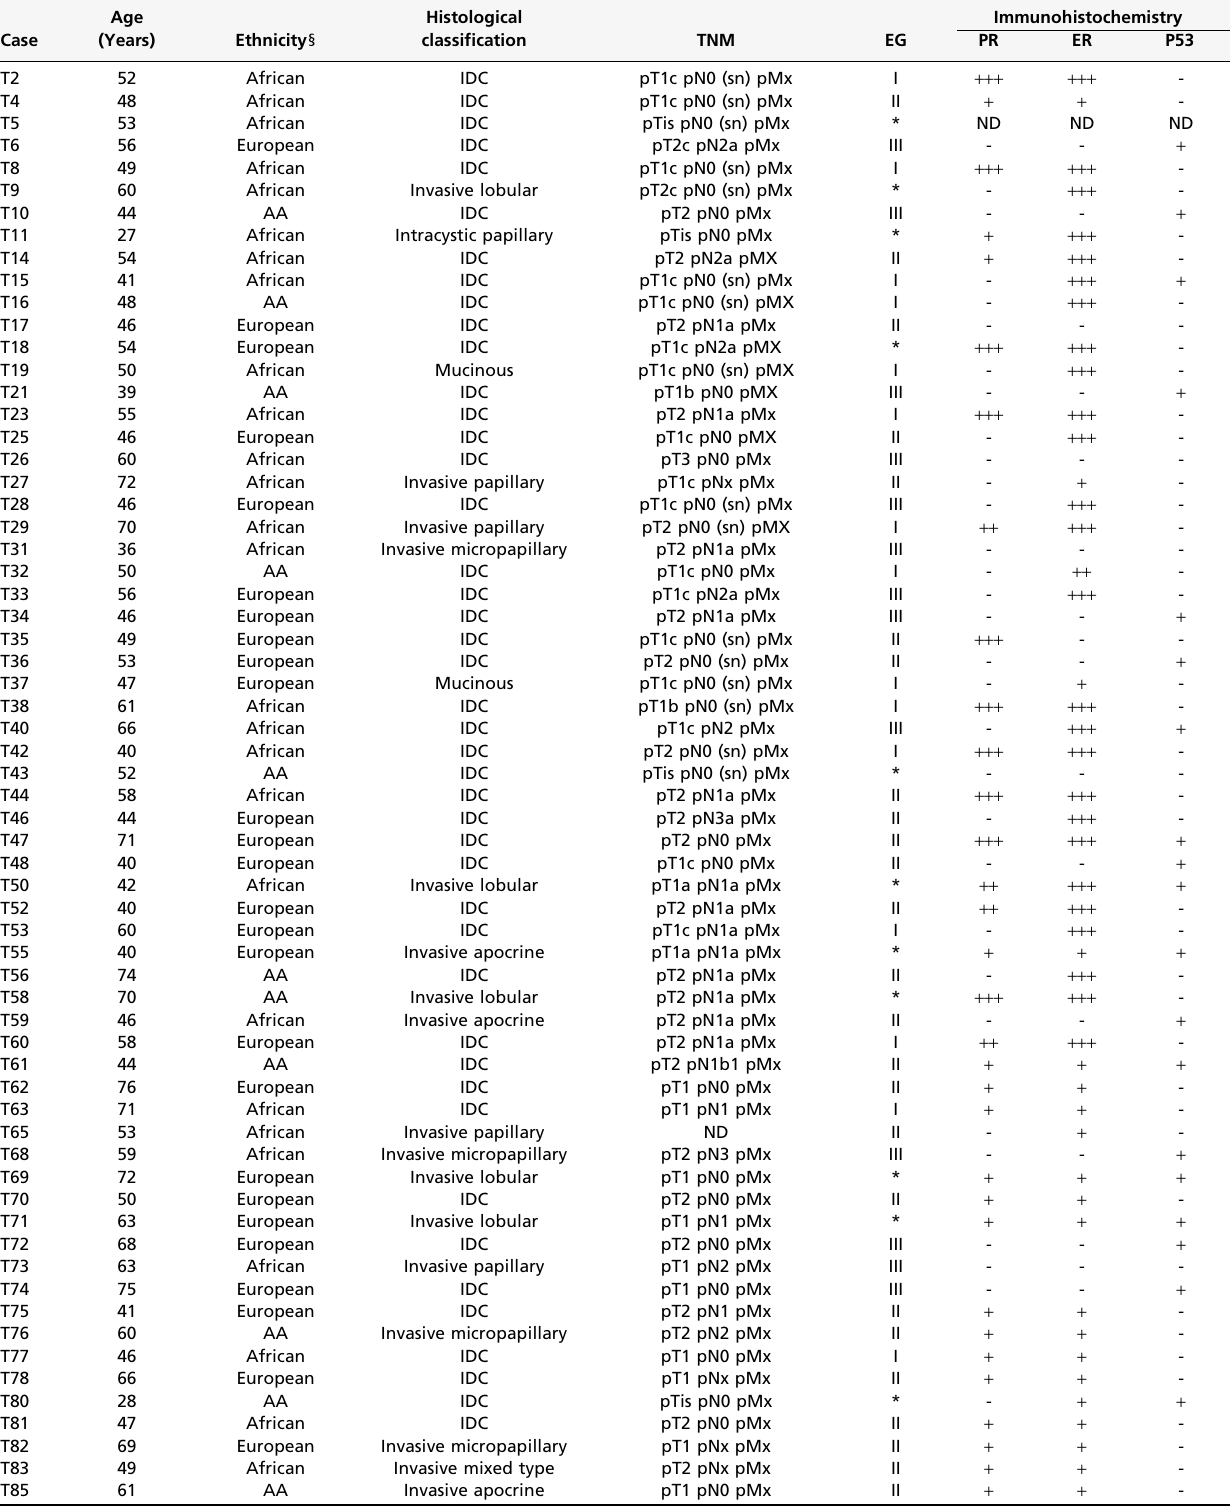
Supplementary Table 2 - Clinical-pathological patient